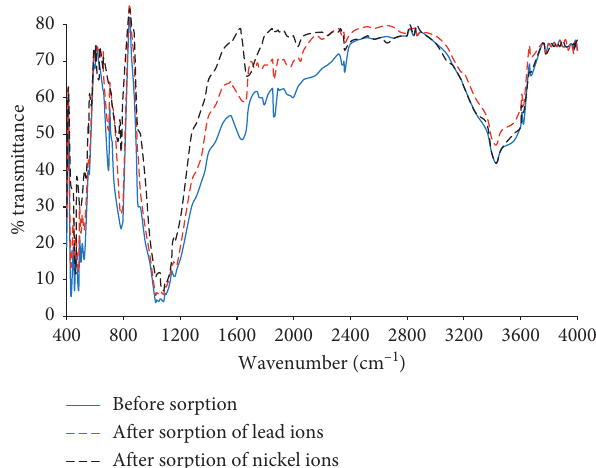
Figure 4: FT-IR analysis of WFS before (reproduced with permission from [44]) and after removal of Pb +2 and Ni +2 ions from aqueous solution. Table 3: Functional groups responsible for Pb +2 and Ni +2 sorption onto WFS.